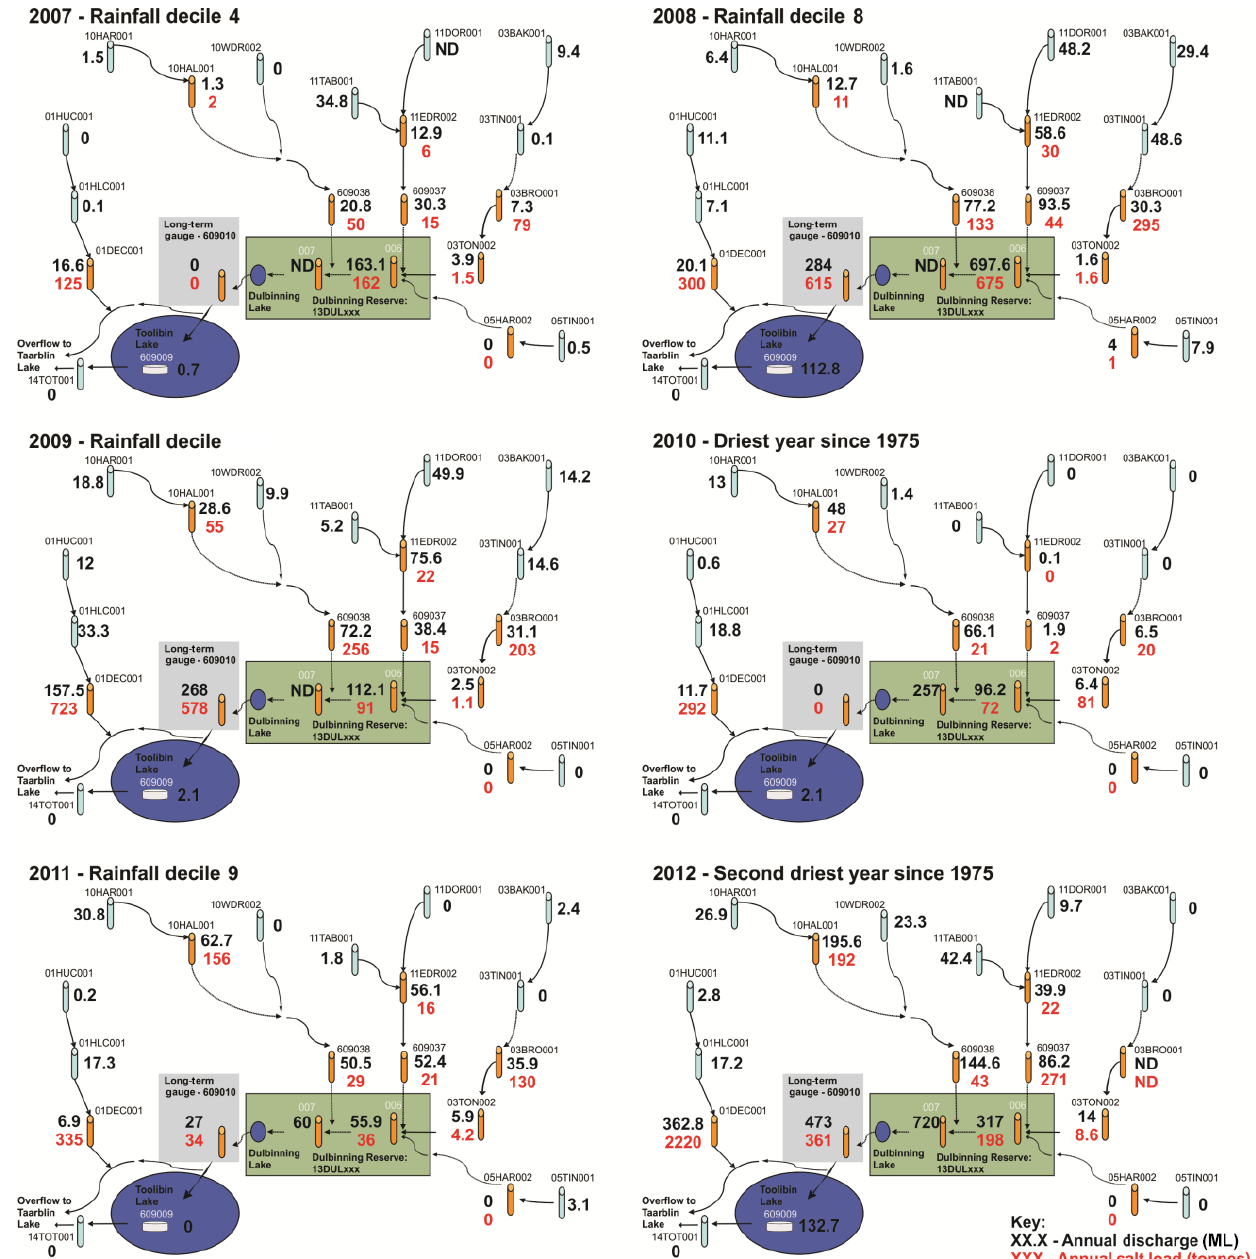
Figure 3. Annual discharge data (ML) (black data) and salt load (tonnes per year in red) for the different gauging stations across the study period (2007–2010). Note that ND is no data due to equipment